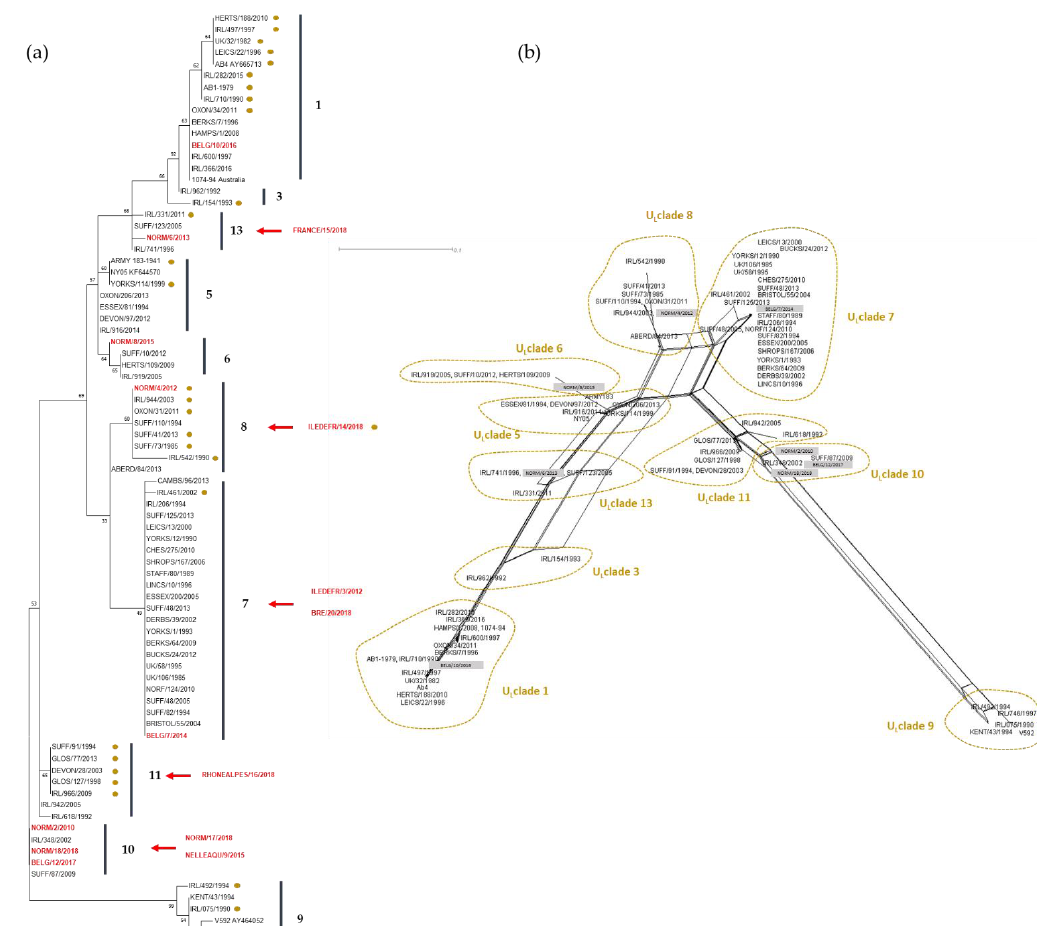
Figure 4. (a) Maximum Likelihood phylogenic tree based on Jones Taylor Thornton model built with MLST sequences including 8 French and Belgian strains (in red), 66 EHV-1 UK strains [14], and 22 EHV-1 Irish strains [26]. Dots indicate D752 strains (Neuropathogenic type). Strains with partial concatenated amino acid sequence were not included in the Maximum Likelihood analysis but their supposed position in the tree is indicated with red arrows according to their clade identification (see Table 6). U L Clades [14] are numbered and represented with vertical lines. Boostrap values after 1000 replication are indicated at major nodes. ( b ) Network built using Neighbour-Net method with the same sequences as the tree. Only 37 amino acid sequences were included in the network, and French and Belgian strains are represented in grey boxes.